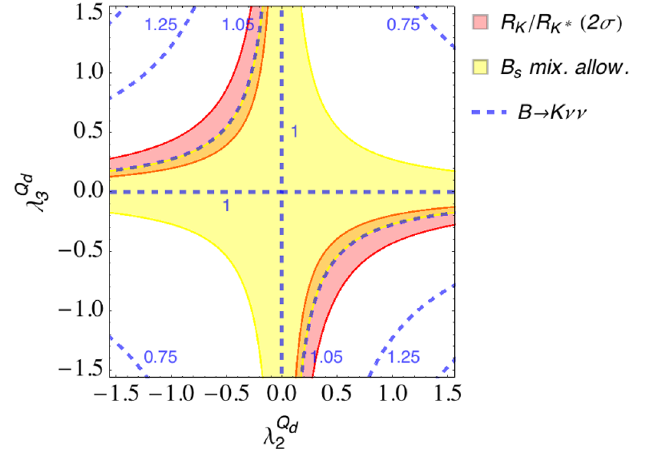
(cid:16) (cid:17) (cid:21) Q d ; (cid:21) Q d plane of the region favoured by b ! s‘‘ according 2 3 = 1 : 7, (cid:21) E = (cid:0) 1 : 3. All the other 2 2